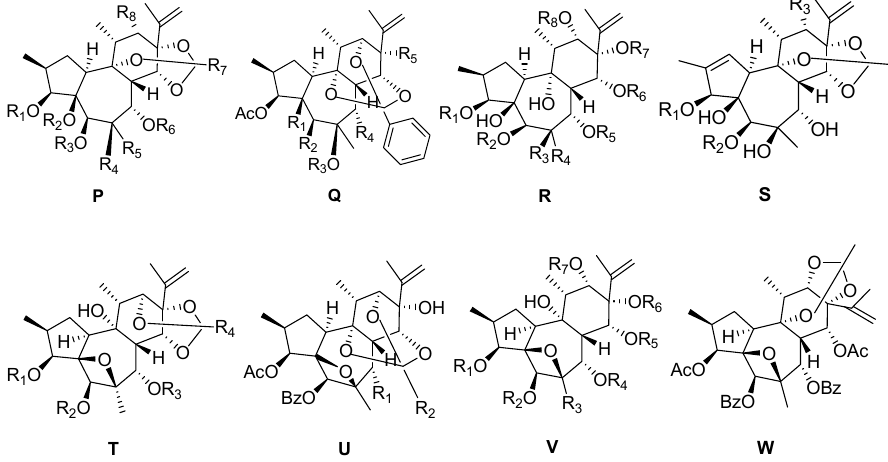
Figure 4. Eight types ( P – W ) of genkwanines skeletons.